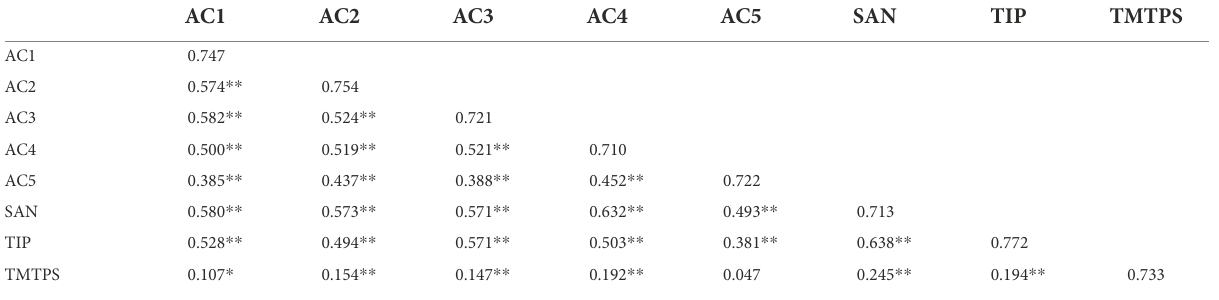
TABLE 4 Discriminant validity test table and correlation coefficient